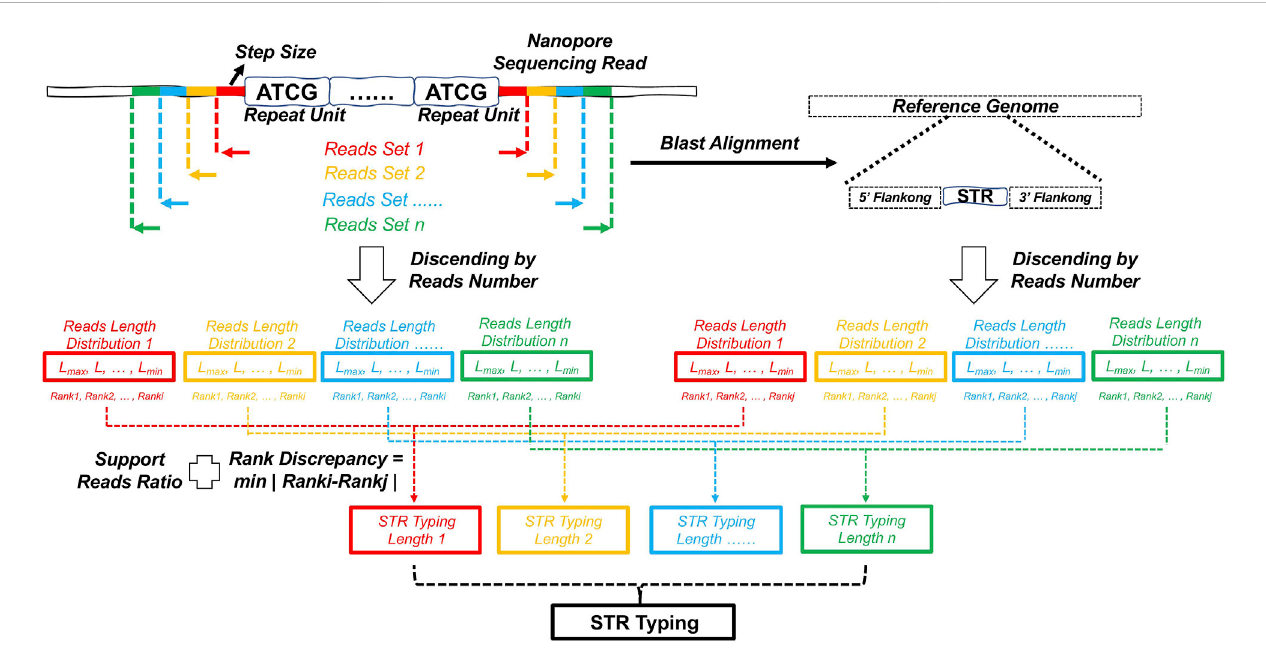
FIGURE 1 Schematic diagram of STR typing with NanoSTR. NanoSTR can be used to genotype STR loci based on multisampling and length-number-rank (LNR) information ofreads.Andthemultiple genotypes arecombinedfor statistical analysis,andtheresultswith themodeand supportedreadnumberareselected as the fi nal genotype for this target STR locus. After that, a secondary correction is performed according to the difference in the order of magnitude of the number of